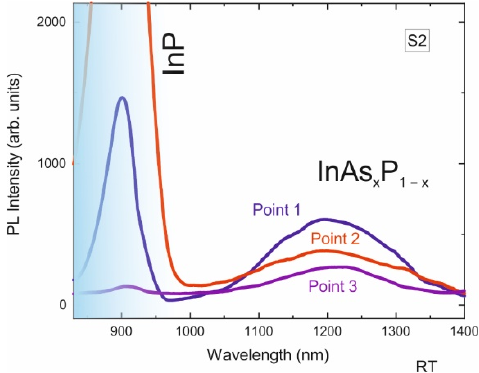
Figure 5. PL spectra obtained at points 1–3 of sample S2 at a pump power density of 127 kW/cm 2 . The position of the PL maximum in the studied nanostructure varies in the spectral range 1193–1220 nm (1.039 eV–1.016 eV). From these data, one can similarly, as was